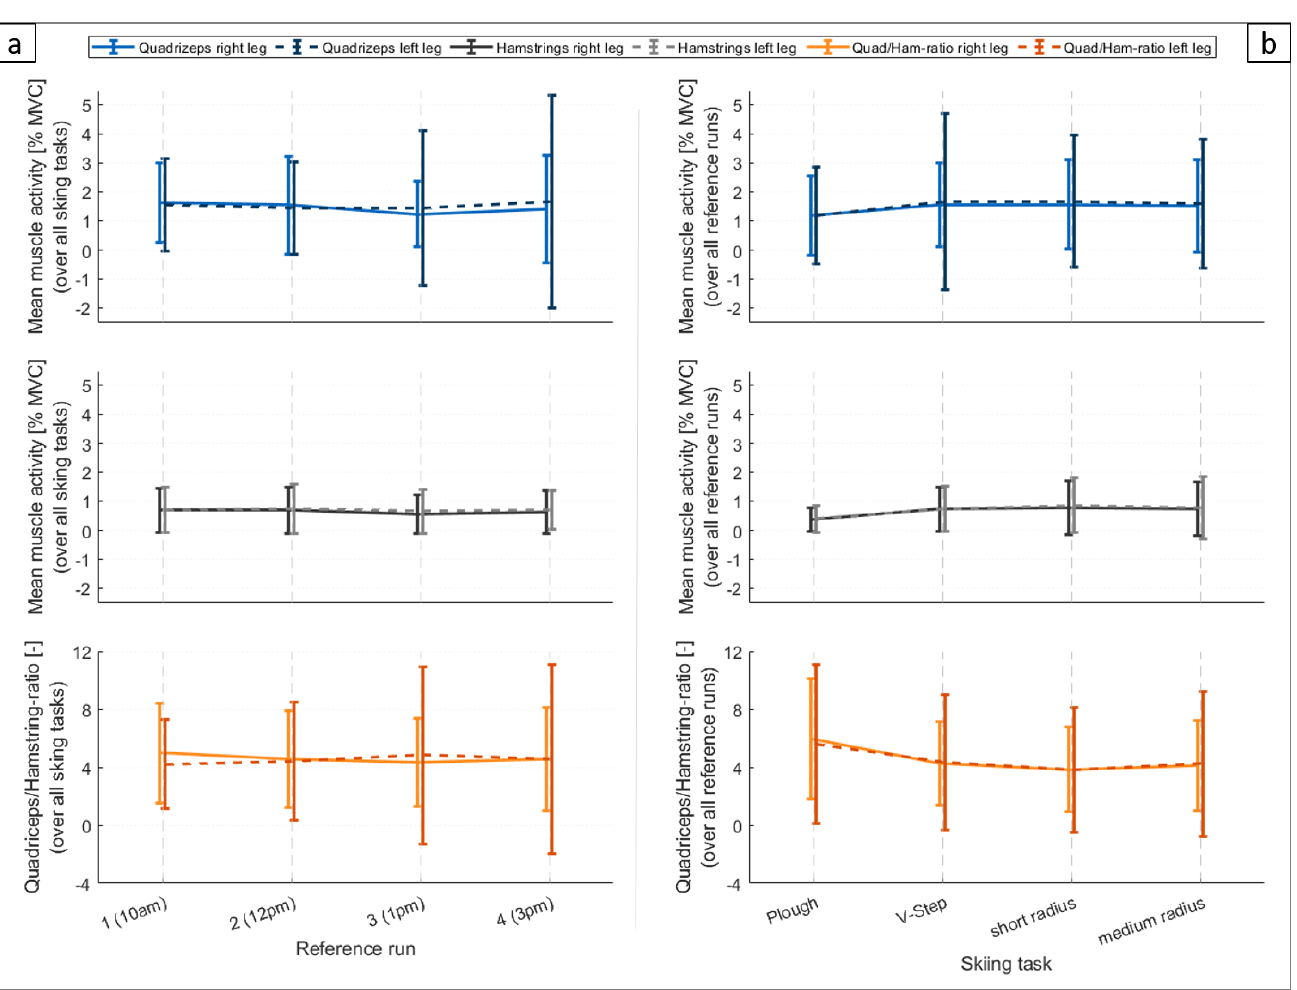
Figure 4. First two lines of graphs: Mean muscle activity in % of the individual reference measurement (maximum voluntary contraction|MVC) for the four different muscle groups. The error bars indicate the standard deviation. Last line of graphs: the ratio of quadriceps/hamstring activation (quad/ham-ratio) is given for the left and right leg. ( a ) mean muscle activity and quad/ham-ratio over all skiing tasks for the four reference runs; ( b ) mean muscle activity and quad/ham-ratio over all four reference runs for the different skiing tasks.